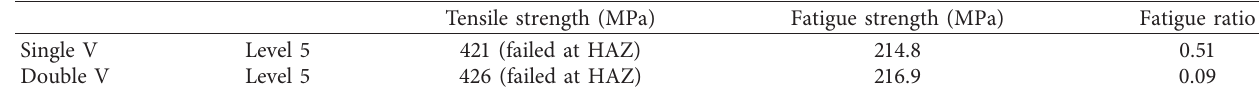
Table 13: Tensile strength for optimal levels.